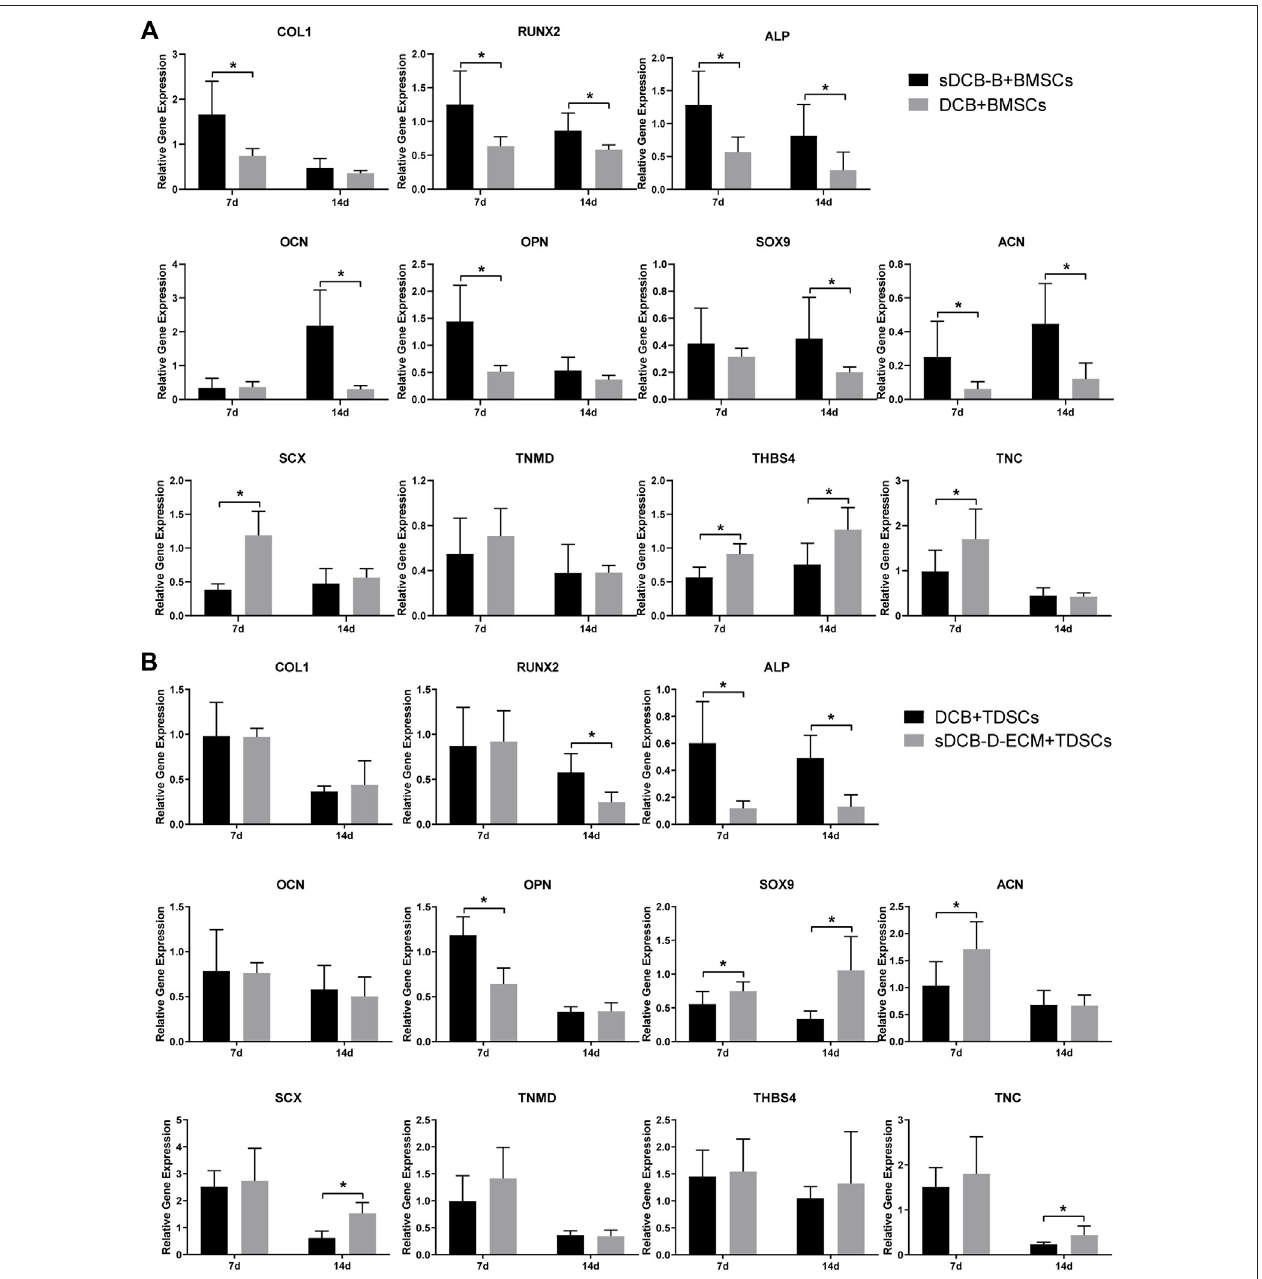
FIGURE7| PCRanalysisofrelativegeneexpressionsinBMSCs (A) and TDSCs (B) at 7and14 days after cultured onscaffolds. Thelevels ofgeneexpression are normalized to GAPDH. * Indicated p < 0.05.